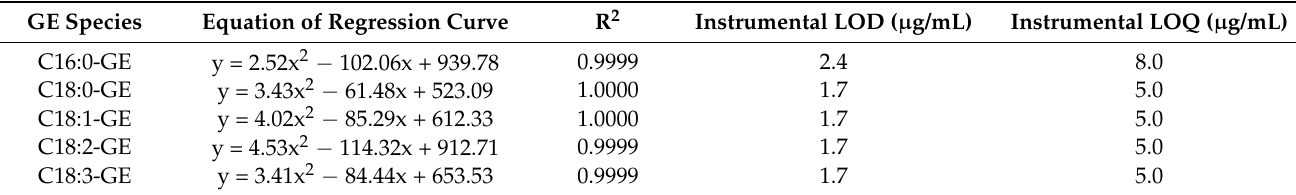
Table 3. Linearity, coefficients of regression (R 2 ), instrumental limit of detection (LOD), and instrumental limit of quantifica- tion (LOQ) of five glycidyl ester (GE) species.